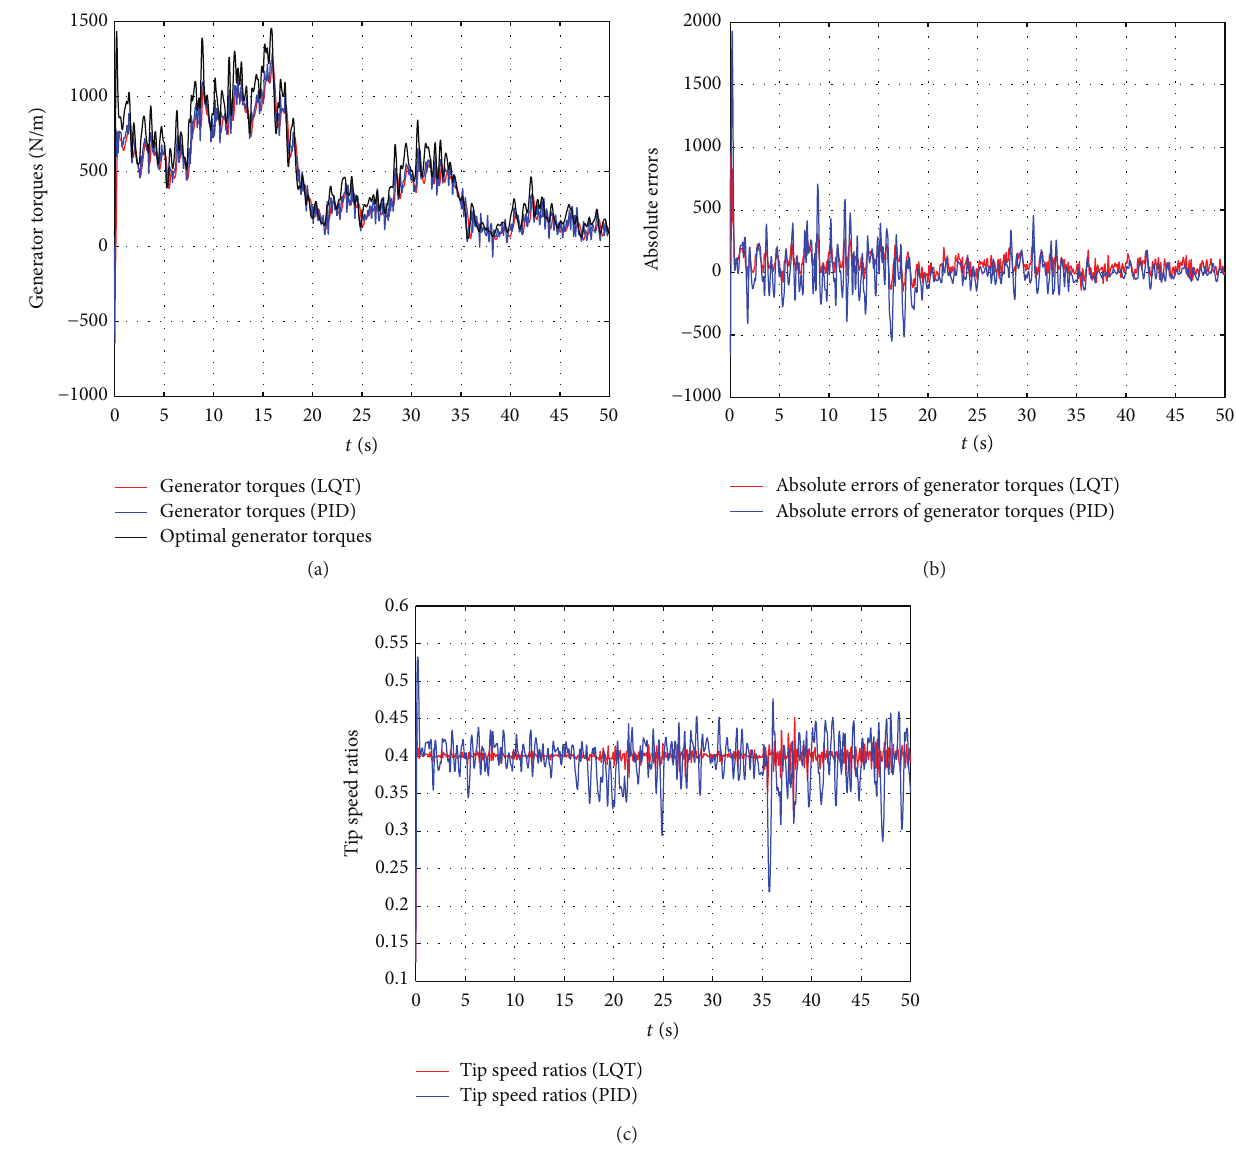
Figure 12: Wave profile responses: (a) actual generator torques, (b) the absolute error of the generator torques, and (c) tip speed